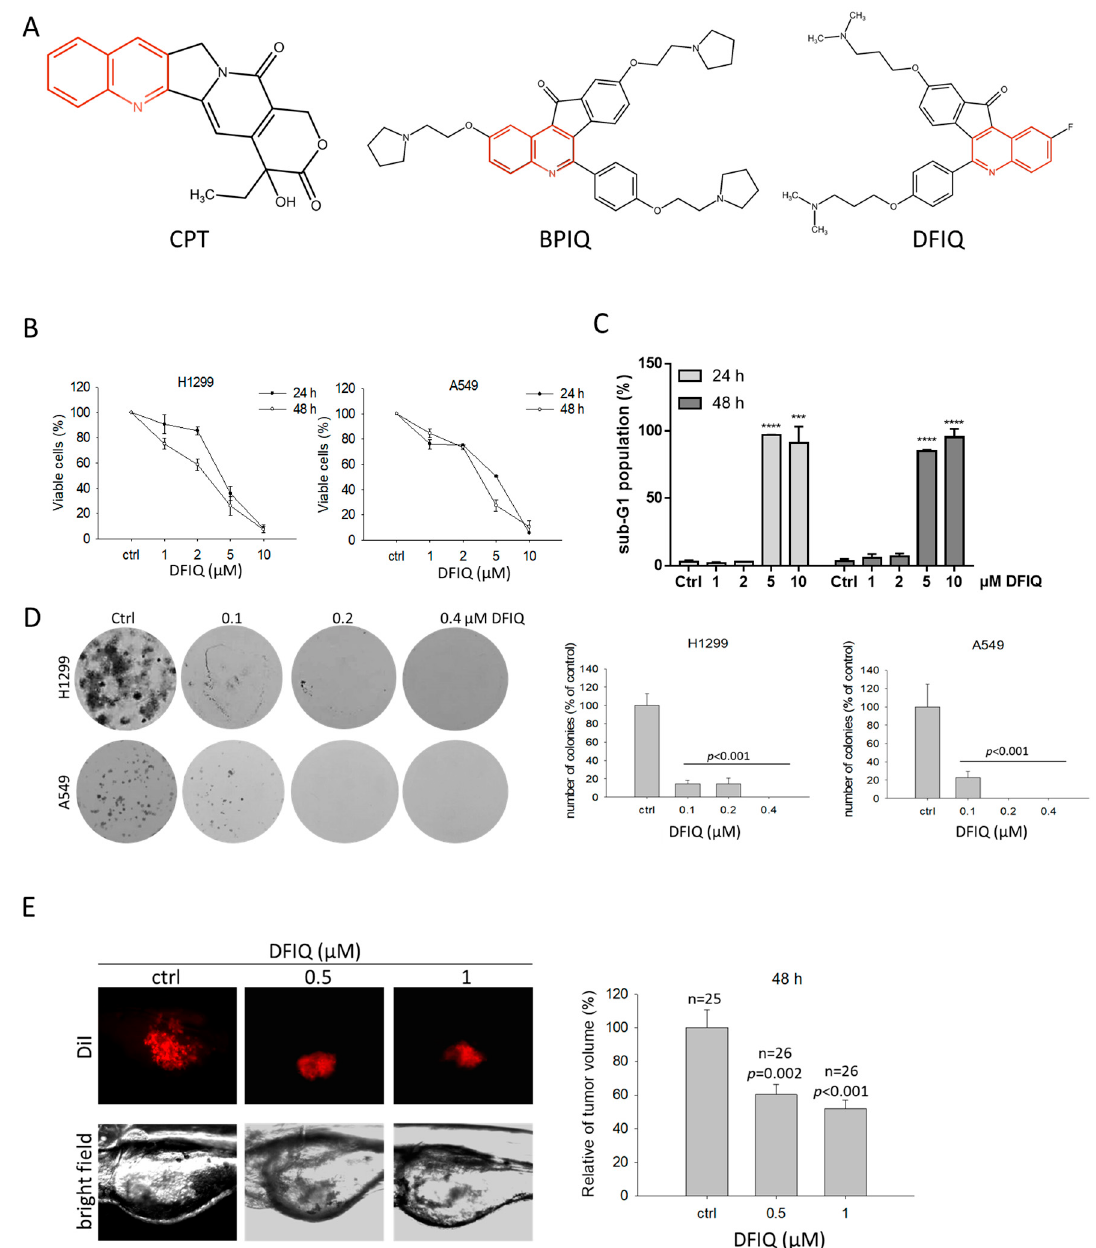
Figure 1. DFIQ inhibited non-small-cell lung carcinoma (NSCLC) cell growth in vitro and in vivo. ( A ) Chemical structures of camptothecin (CPT), BPIQ, and DFIQ. The quinoline scaffold is marked in red. ( B ) The NSCLC cell lines A549 and H1299 were treated with different doses of DFIQ, and cell viability was measured at 24 and 48 h after treatment. ( C ) We measured the proportion of sub-G1 cells among DFIQ-treated H1299 cells at 24 and 48 h. *** p < 0.001, **** p < 0.0001 compared to the control group. ( D ) Measurement and quantification of colony formation of A549 and H1299 cells treated with DFIQ. ( E ) Growth inhibitory activity of DFIQ in NSCLC cells in the zebrafish xenograft model at 48 h after treatment.